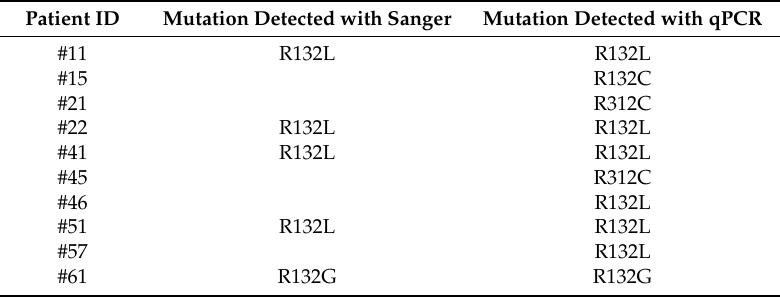
Table 4. IDH1 hotspot mutations detected with the two techniques, respectively.